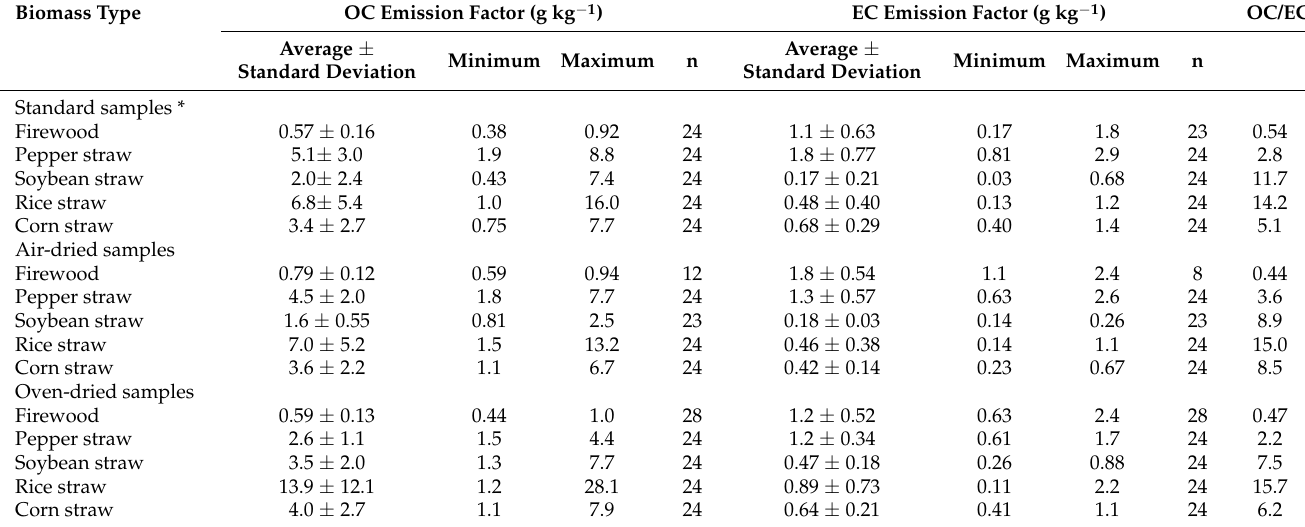
Table 2. OC and EC emission factors for residential biomass burning (unit: g kg − 1 dry biomass).